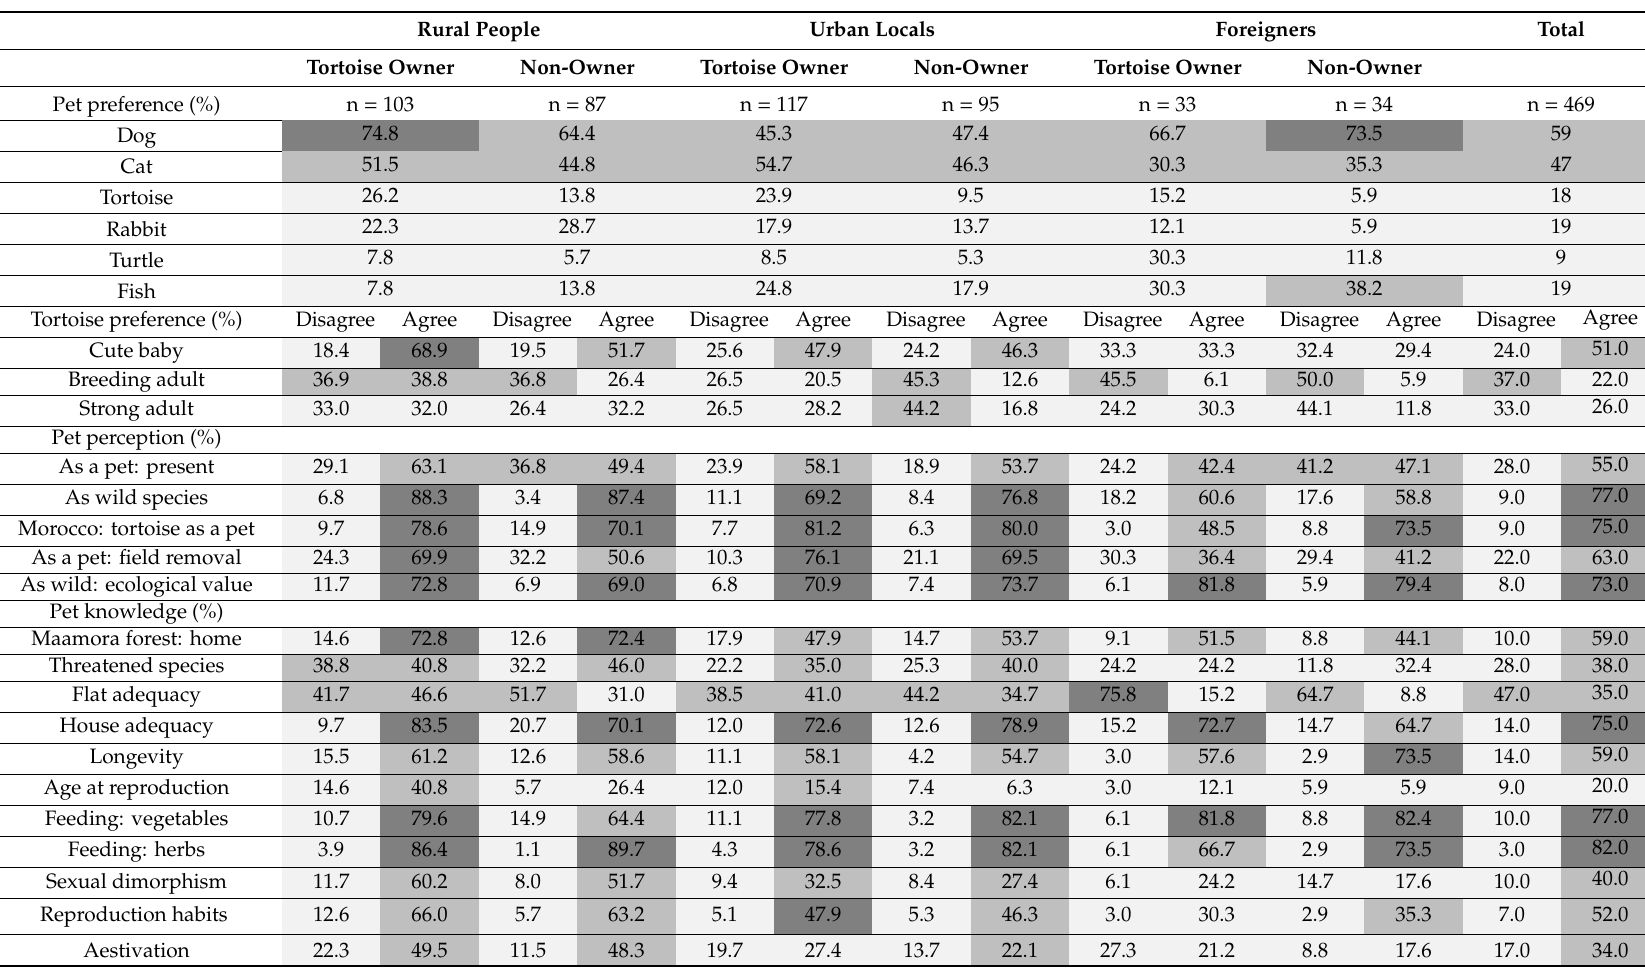
Table 2. Tortoise owners’ and non-owners’ pet preferences, perceptions, and knowledge. The percentages are highlighted with di ff erent intensities of colors according to their level: dark grey = over 67%, medium grey = 34%–66% and light grey = less than